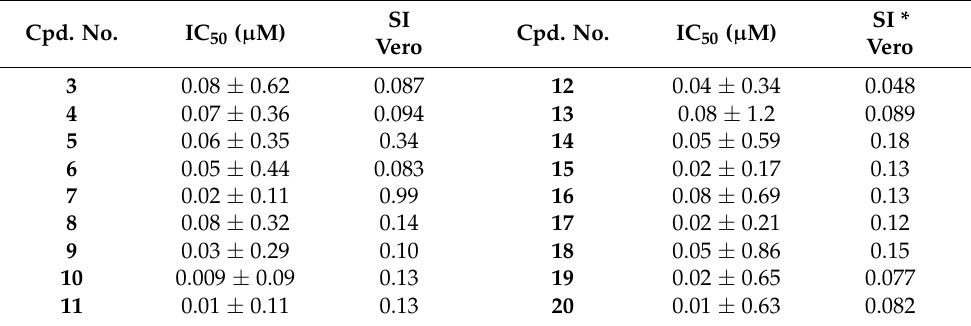
Table 3. IC 50 of the semi-synthesized compounds on Caco-2 cancer cell line and the selectivity index on Vero normal cell line. Results are the average of triplicates. Cpd. No. IC 50 ( µ M) Cpd. No.